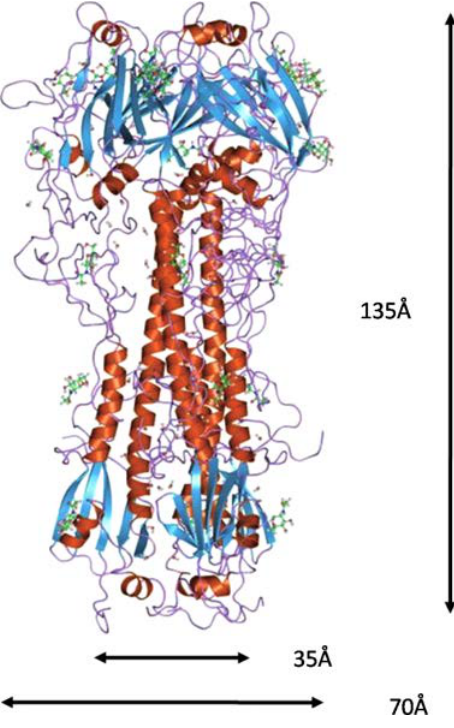
Fig. 3. The trimeric structure of HA